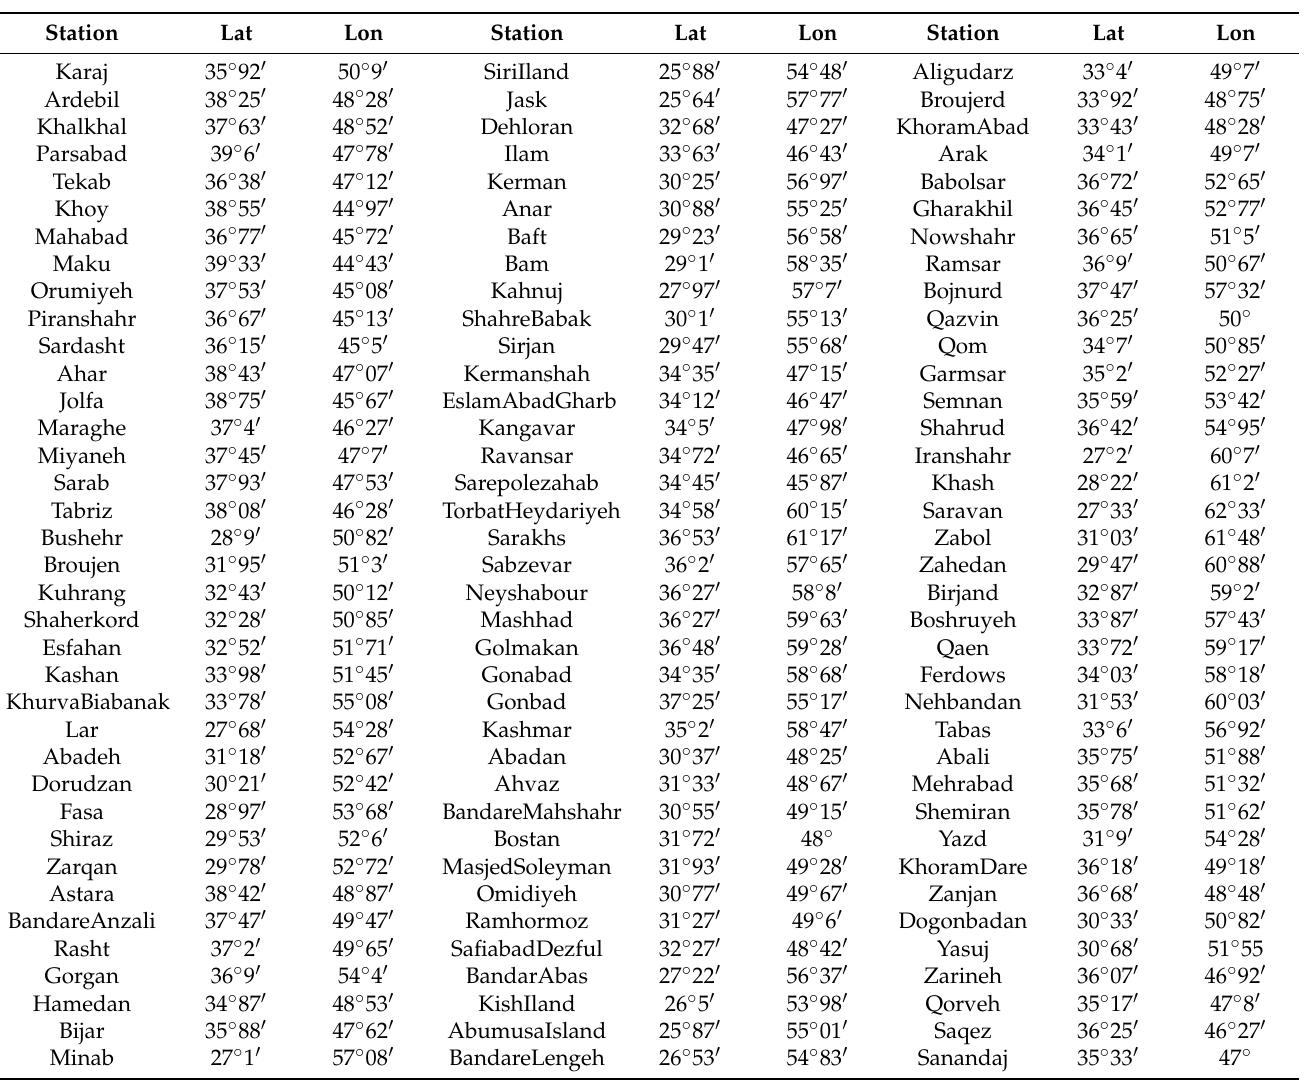
Table 1. Synoptic stations in